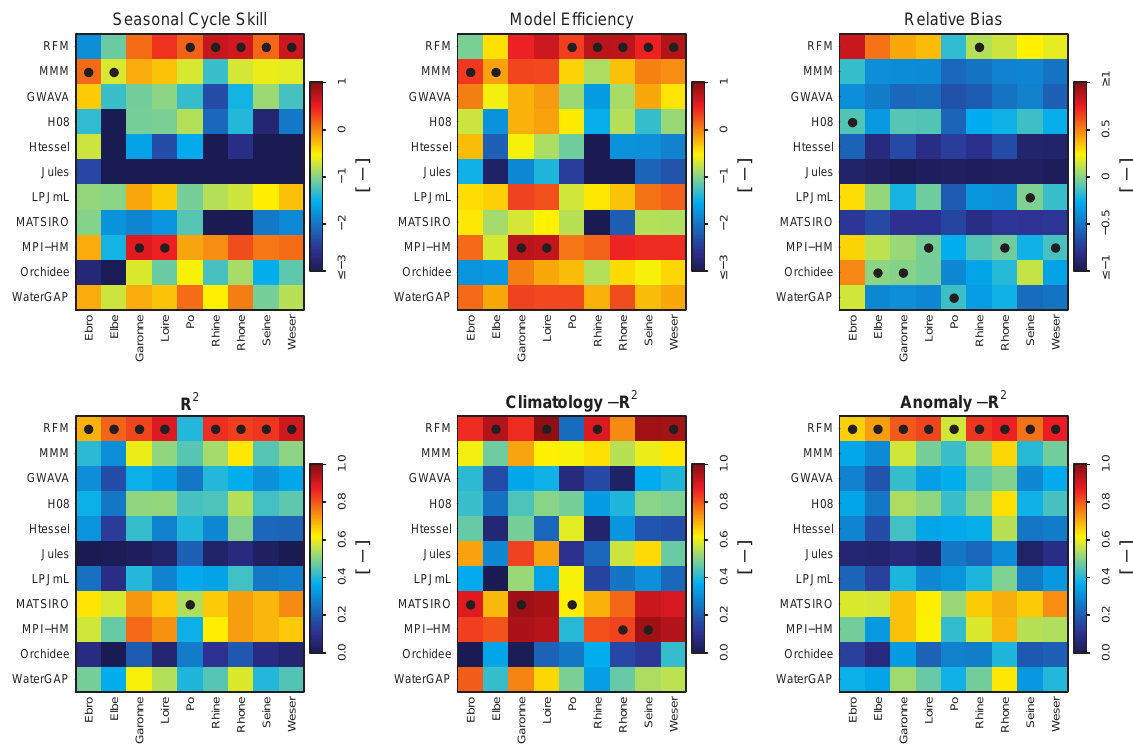
Figure 10. Basin-scale validation (B): performance of the random forest model with full atmospheric forcing compared to the performance of the considered LSMs. Model performance is assessed with respect to continental-scale river discharge, quantified using six different performance metrics. The best performing model for each river is marked by a